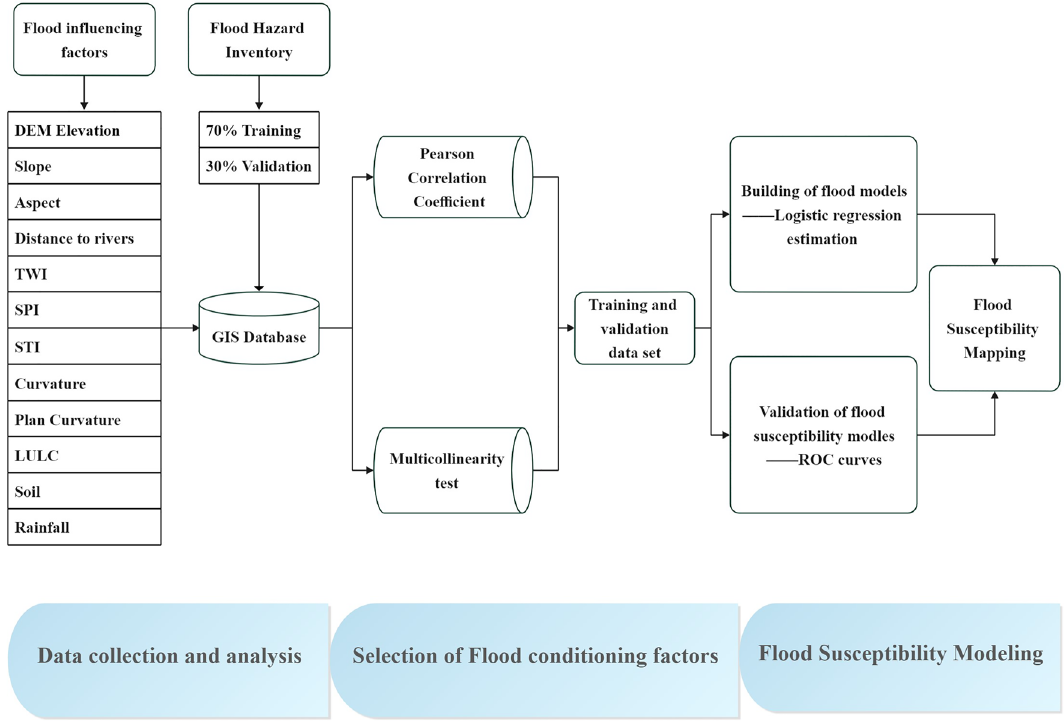
Figure 1. The working framework for flood sensitivity